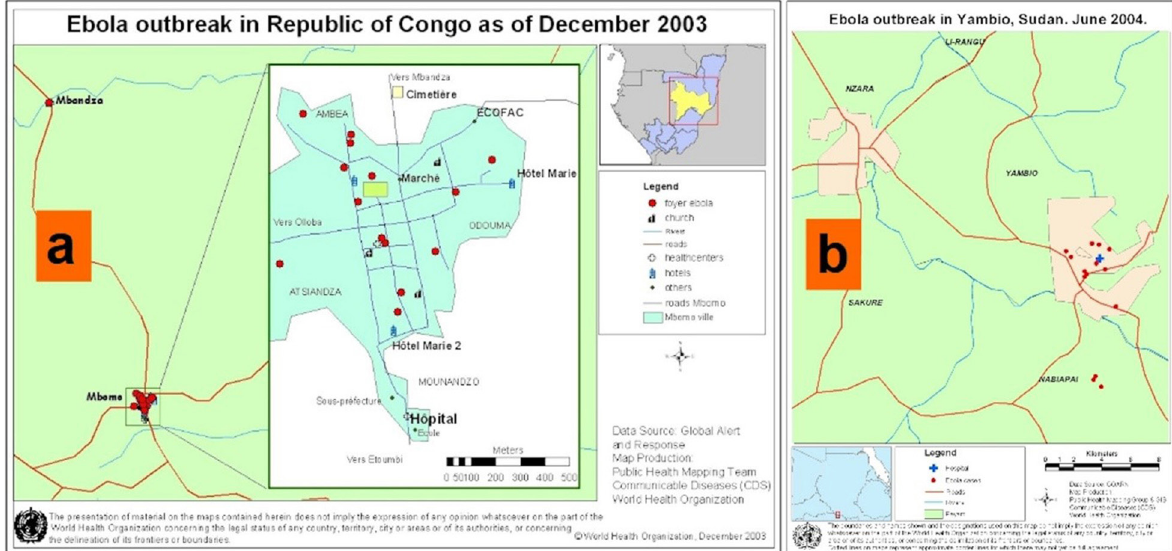
Fig. 2. Maps provided by WHO. a – 2003 epidemic in Mbomo, Republic of Congo (Congo Brazza). b – 2004 epidemic in Yambio, then Sudan, now South Sudan. Source: own elaboration based on https://www.who.int/data/gho/map-gallery-search-results?&maptop- ics=22730bde-25e7-49e9-ae78-8ee9cdd6f65c (Creative Commons Attribution-NonCommercial-ShareAlike 3.0). WHO – World Health Organization.